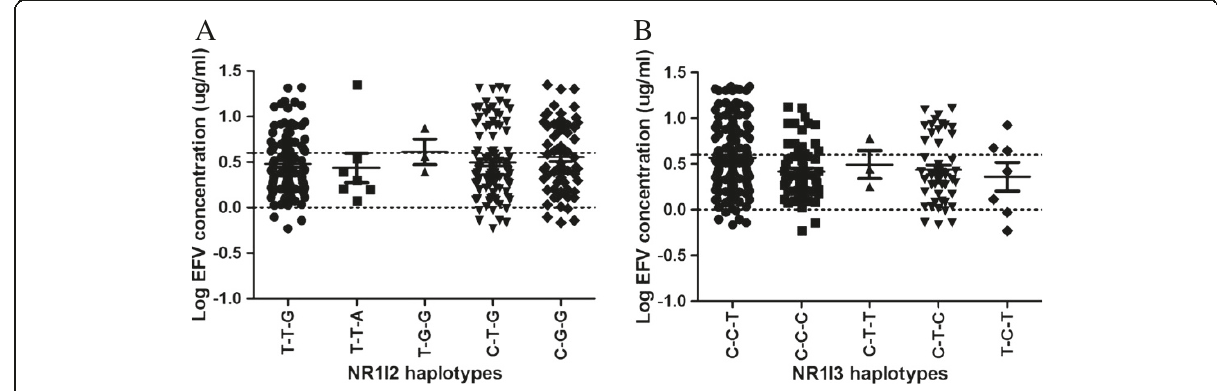
Figure 3 A-B: Effects of NR1I2 and NR1I3 haplotypes on plasma efavirenz concentration. The therapeutic range for efavirenz is shown. NR1I2 C-T-T and NR1I3 T-C-C haplotypes were only observed once and thus excluded from the